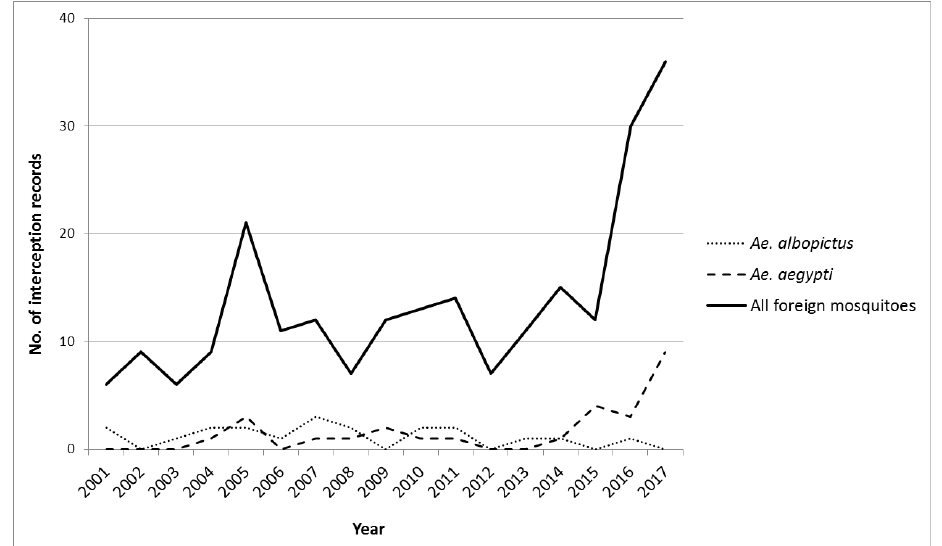
Figure 3. Ae. aegypti , Ae. Albopictus , and total foreign mosquito interception records in New Zealand, July 2001–December 2017.